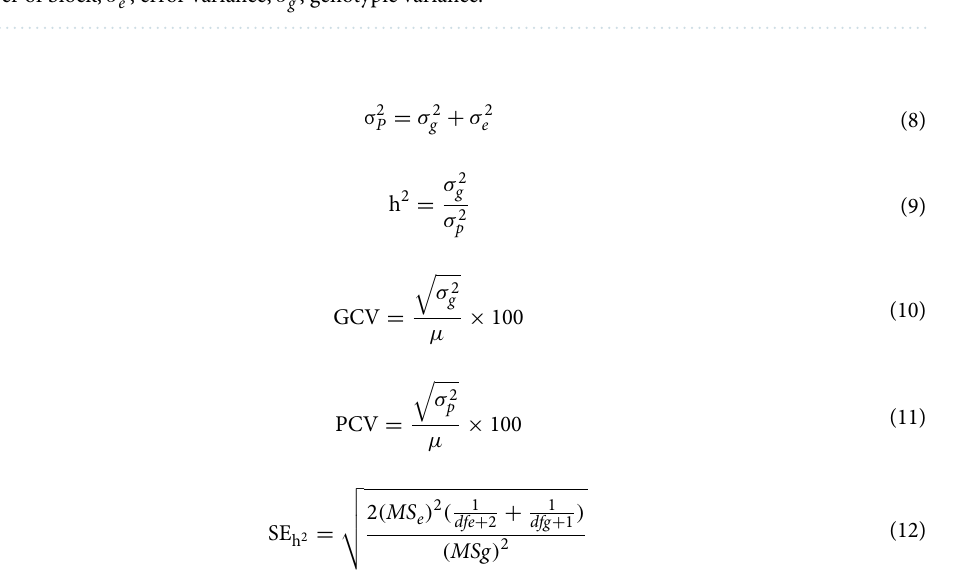
Table 2. Expected mean squares for phytochemicals and forage yield traits across two environments (non- stress and drought stress) and in 2018 and 2019 seasons for evaluation of Poa pratensis accessions. g, genotype; 2 σ 2 r, number of block, σ g , genotypic e , error variance;